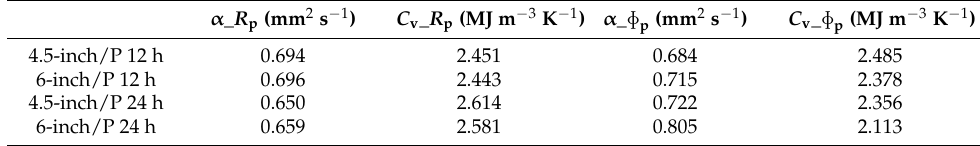
Table A2. Thermal property estimation for validation of the analytical procedure.